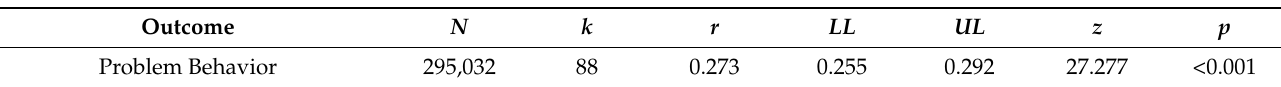
Table 4. Analysis results of random effect